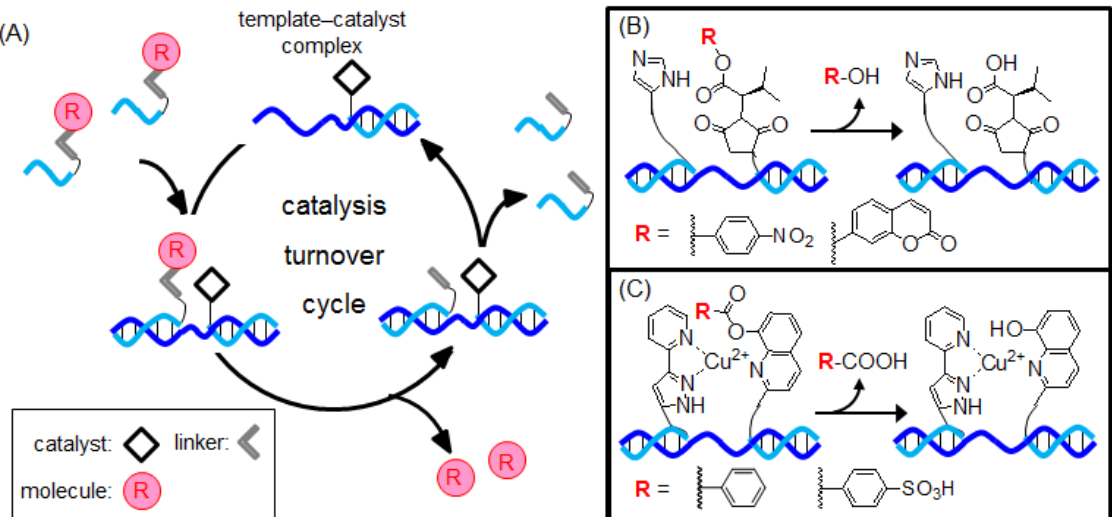
Figure 3. ( A ) Molecular release via templated catalysis; ( B ) organocatalyzed ester hydrolysis reaction; and ( C ) metal-catalyzed hydrolysis